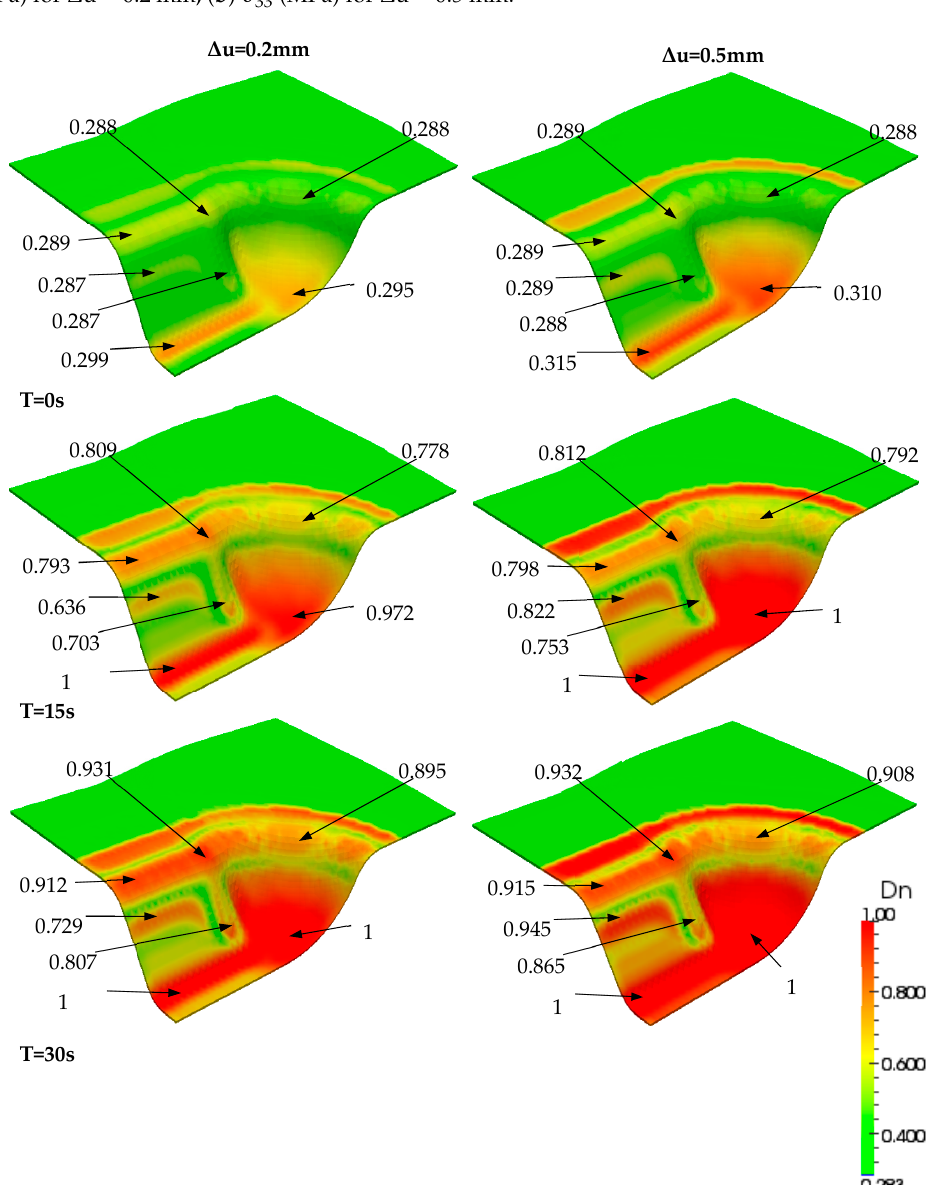
Figure 13. Comparison between two simulation results under a compaction displacement of Δ u = 0.2 mm (left) and Δ u = 0.5 mm (right) during the first 30 s.